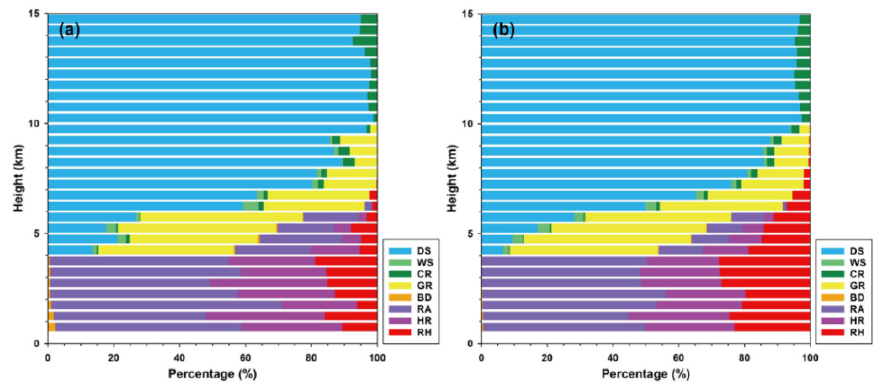
Figure 10. The stacked frequency (unit: %) of each identified hydrometeor by altitude for the CCs at ( a ) CS1 and ( b ) CS2. The meanings of each color for identified hydrometeors are listed in the legend. The analysis period of CS1 and CS2 is as in Figure 8.